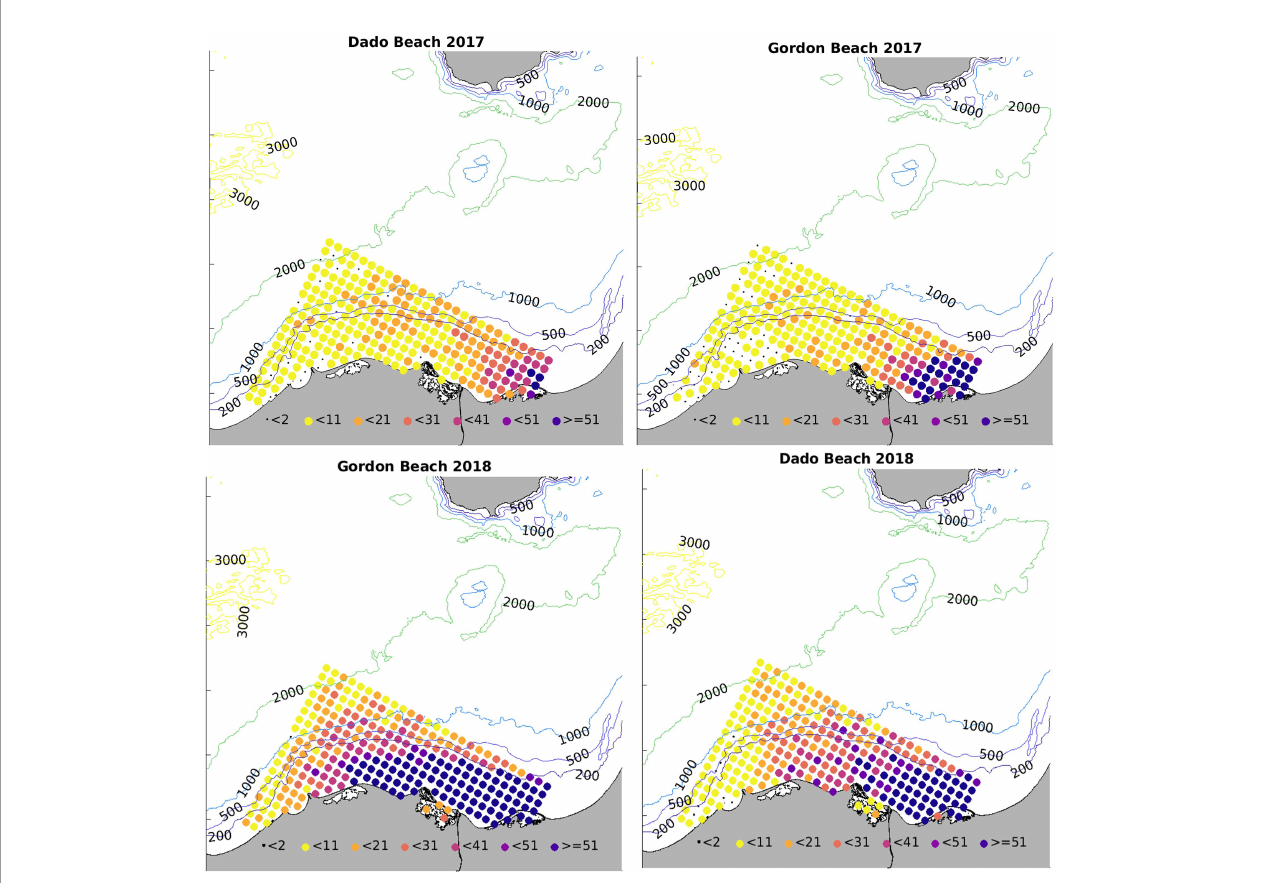
FIGURE 5 | Colour-coded release points off the Egyptian coast according to particle hit distribution on Israeli target beaches in 2017 and 2018, averaged across both release depths of 8 m and 15 m. The numbers refer to hits at Gordon (Tel Aviv) and Dado (Haifa) for every release